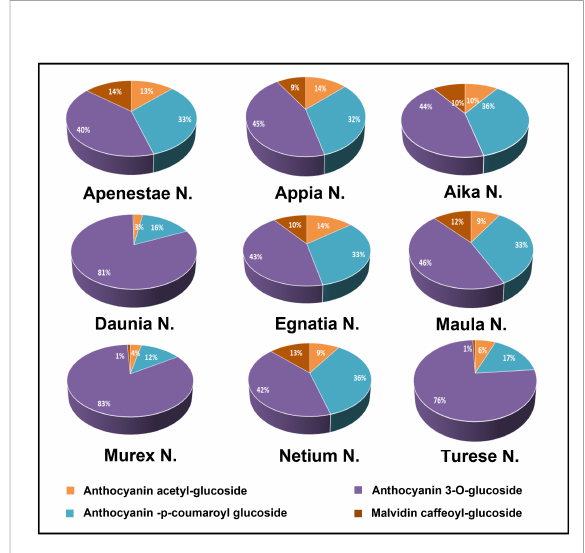
FIGURE 3 Grape skin anthocyanin composition of the new genotypes: the single classes of compounds were expressed as relative percentages (%) of the sum of M + signal intensities recorded in the positive-ionization UHPLC/QTOF chromatogram.